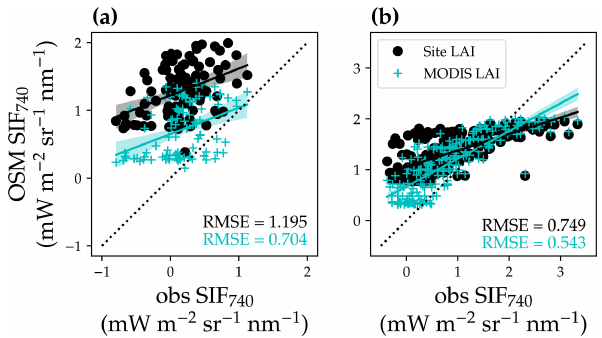
Figure 16. Comparison of modeled and satellite-observed solar- induced chlorophyll fluorescence at 740nm (SIF 740 ). (a) Compari- son for the US-NR1 flux tower site (evergreen gymnosperm forest). The black circles plot the comparison with modeled SIF using a constant site LAI, and the cyan “ + ” symbols plot the comparison using a variable MODIS LAI time series. The black line with shaded confidence interval regions plots the linear regression for the black circles ( y = 0 . 40 x + 1 . 22, R 2 = 0 . 17, P < 0 . 001). The cyan line with shaded regions plots the linear regression for the cyan sym- bols ( y = 0 . 39 + 0 . 65, R 2 = 0 . 14, P < 0 . 001). (b) Comparison for the US-MOz flux tower site (deciduous angiosperm forest). The lin- ear regressions are y = 0 . 32 x + 1 . 05, R 2 = 0 . 54, P < 0 . 001 for the black circles and y = 0 . 55 x + 0 . 67, R 2 = 0 . 69, P < 0 . 001 for the cyan